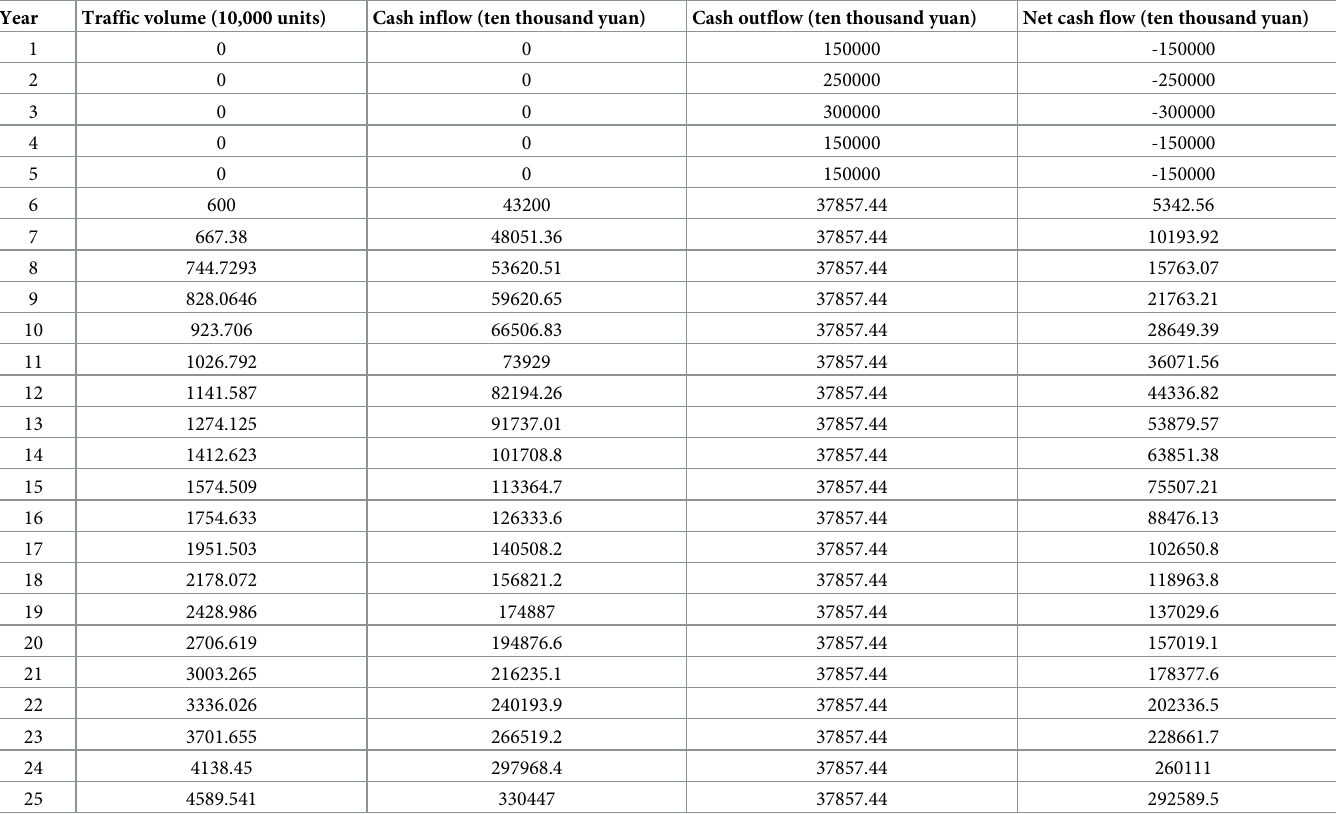
Table 4. Simulation data of this